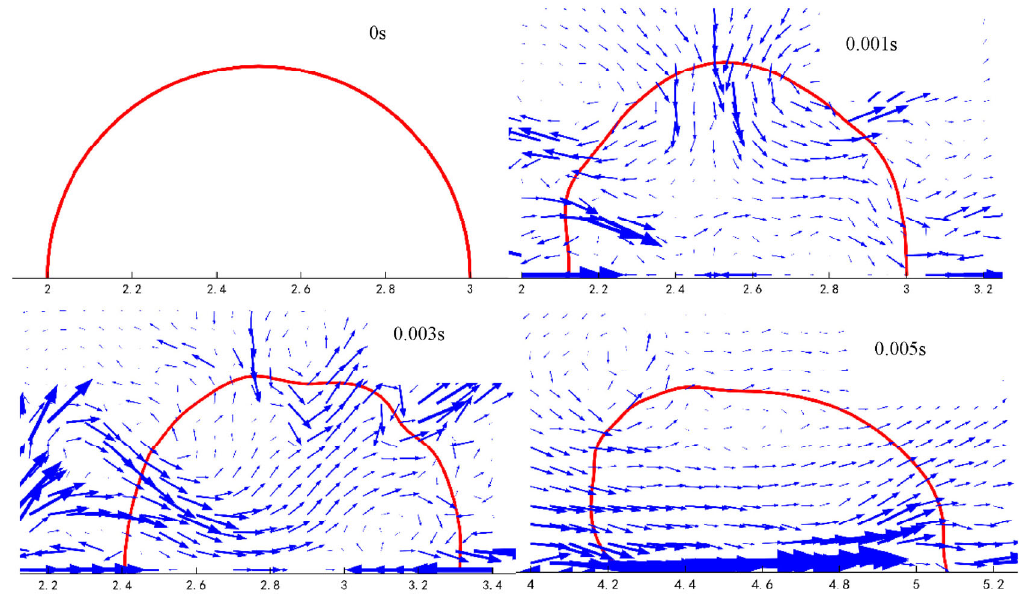
Fig. 15 Change of flow field of molten silicon droplet on corundum substrate ( θ = 90°) during motion